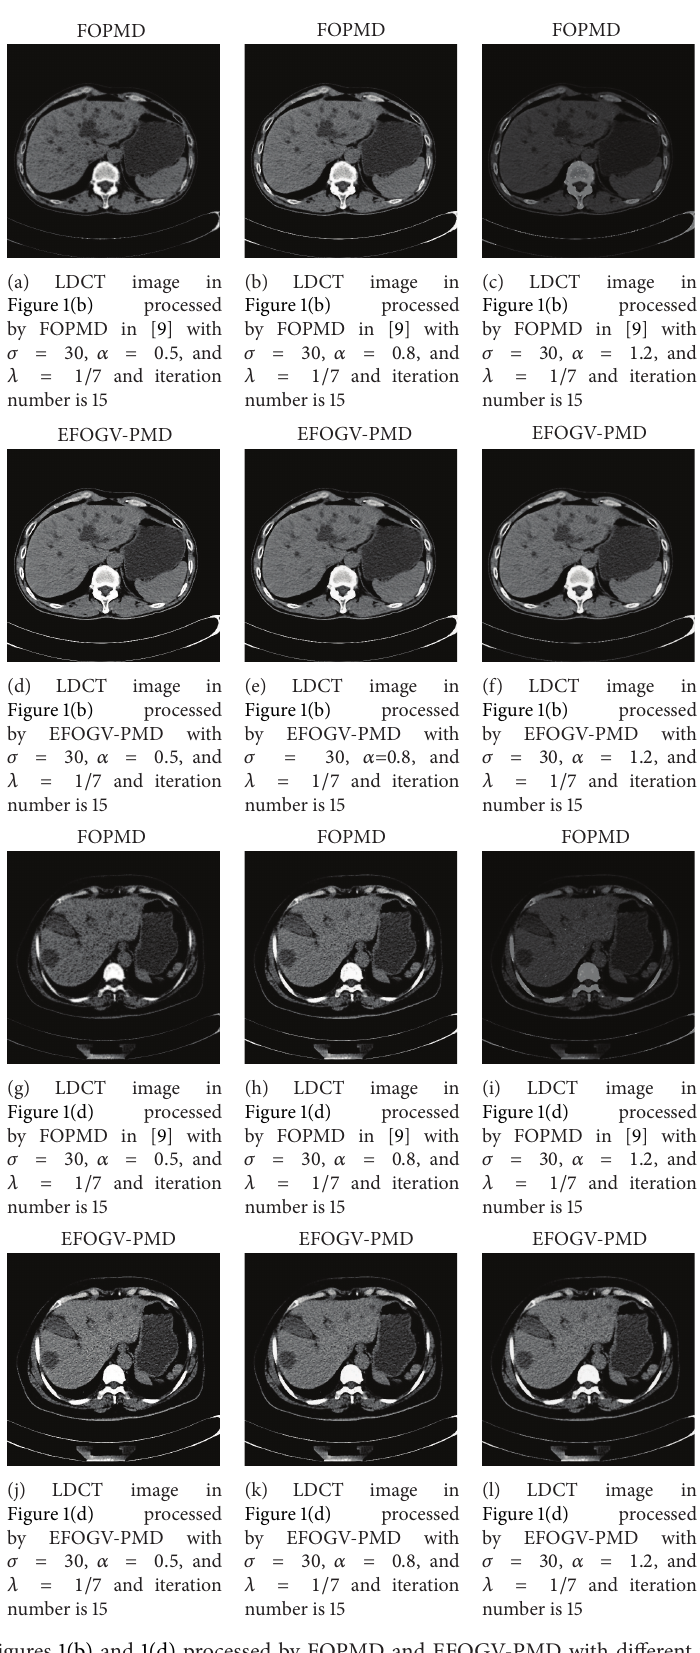
Figure 2: LDCT images in Figures 1(b) and 1(d) processed by FOPMD and EFOGV-PMD with different fractional-orders and iteration number is set to 15. The first column: 𝛼 = 0.5 ; the second column: 𝛼 = 0.8 , the third column: 𝛼 = 1.2 . The first row: Figure 1(b) processed by FOPMD;thesecondrow:Figure 1(b)processedbyEFOGV-PMD;thethirdrow:Figure 1(d)processedbyFOPMD;thefourthrow:Figure 1(d) processed by